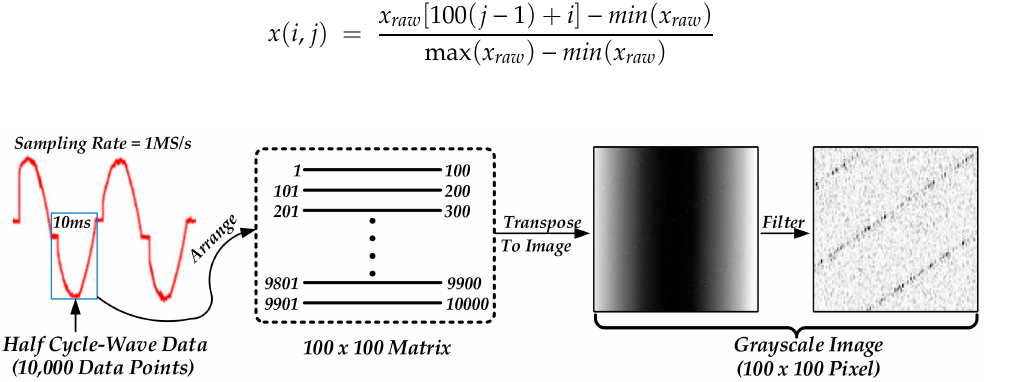
Figure 4. Preprocessing of experimental raw data.